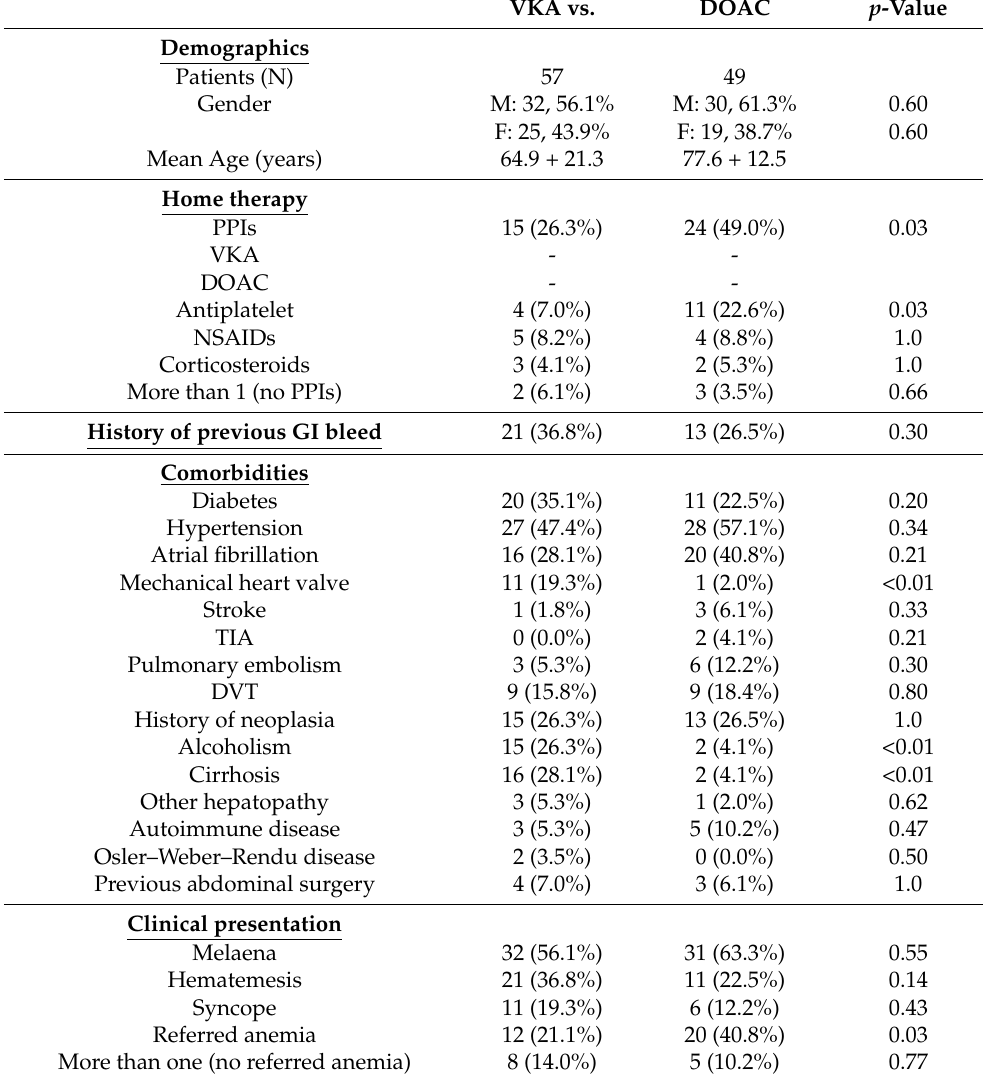
Table 1. Patients’